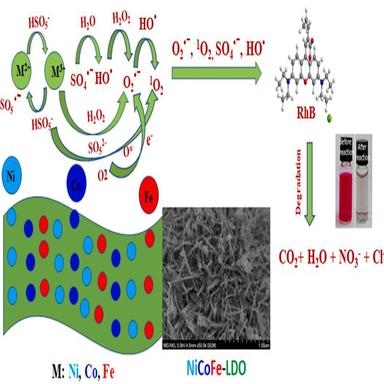
Proposed mechanism for decomposition of RhB in water using NiCoFe-LDO material for PMS activation.